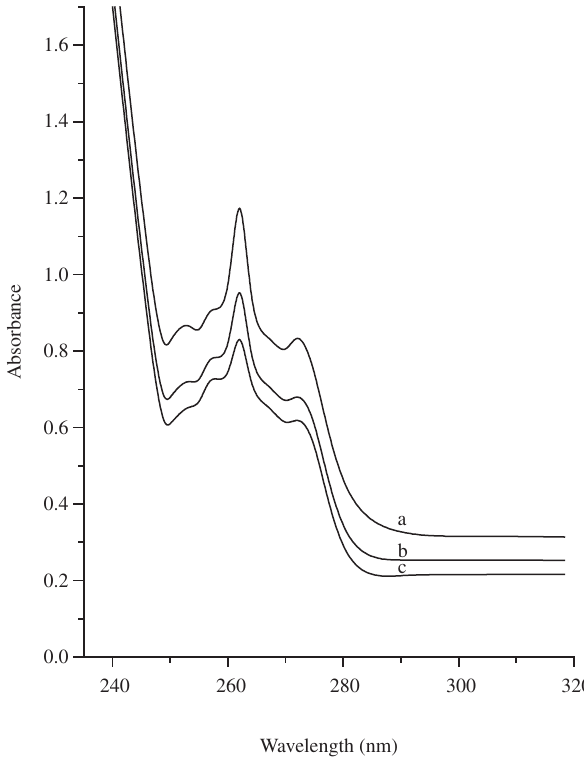
Figure 5. UV-Vis spectra of a) pure Ibuprofen, b) Ibuprofen dispersed silica microsphere and c) Ibuprofen encapsulated silica microsphere prepared from Tween 80 and Span 80 surfactant